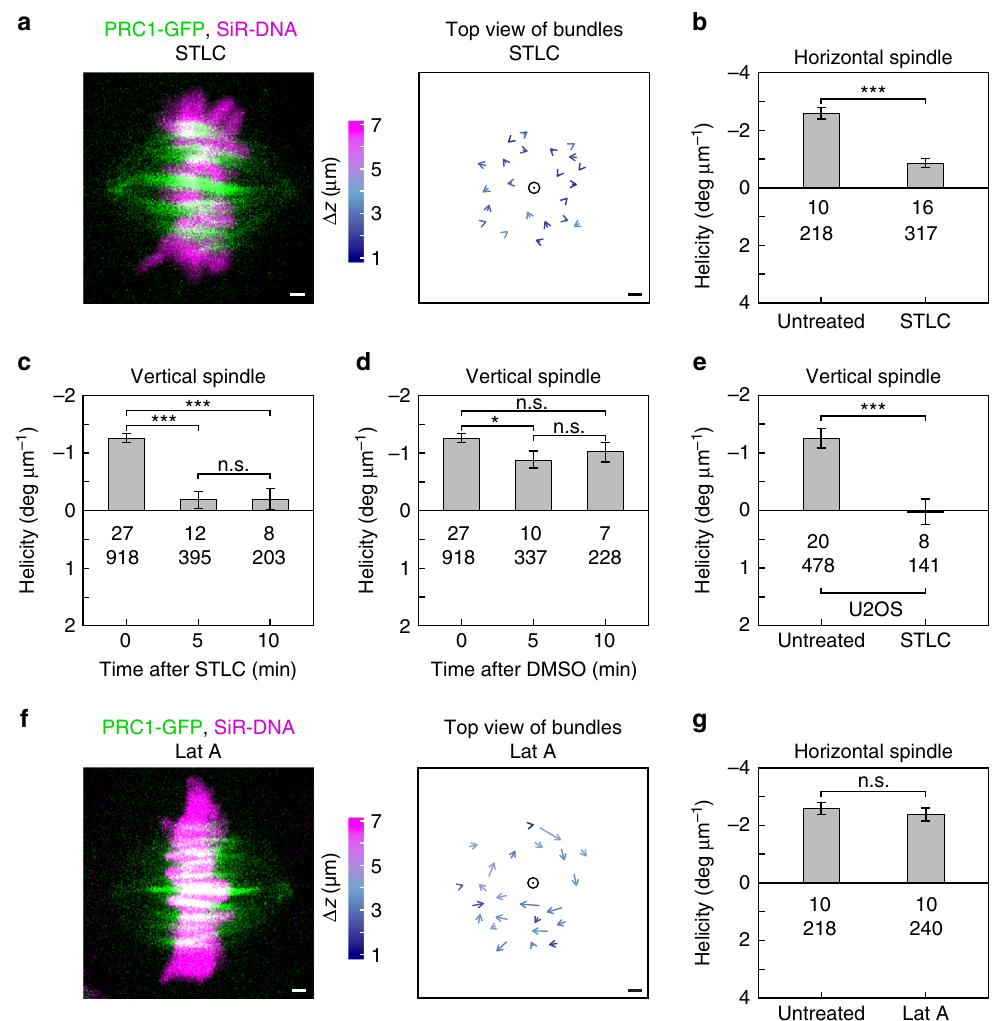
Fig. 2 Kif11/Eg5 inactivation by STLC reduces spindle chirality, whereas latrunculin A treatment does not. a Horizontal spindle in a live HeLa cell expressing PRC1-GFP with SiR-DNA-labeled chromosomes, treated with STLC (left); arrows connecting starting and ending points of bundles traced upwards, from the same cell (right). Circle denotes spindle axis, and colors show z -distance between starting and ending points, see color bar. b – e Helicity of spindles before and after STLC or DMSO (mock) treatment, as indicated. c Helicity before treatment was different from zero ( p = 10 − 44 ), but not at 5 and 10 min ( p = 0.21 and 0.28). d All helicities were different from zero ( p = 10 − 44 , 7 × 10 − 9 , and 4 × 10 − 9 at 0, 5, and 10 min). f Spindle of a live HeLa cell treated with latrunculin A, legend as in a . g Helicity before and after treatment with latrunculin A. In all panels live HeLa cells expressing PRC1-GFP were used, except in e where live U2OS cells expressing CENP-A-GFP and mCherry- α -tubulin were used. In b – e and g , numbers represent the number of cells (top) and bundles (bottom), from 5 independent experiments in b - e and from 4 independent experiments in g ; *** p < 0.001, *0.01 < p < 0.05, n.s., not signi fi cant; all p values from a Student's t- test (two-tailed and two-sample unequal-variance) are given in Supplementary Fig. 2a. Images are maximum intensity projections of fi ve central planes. Scale bars, 1 μ m; error bars,